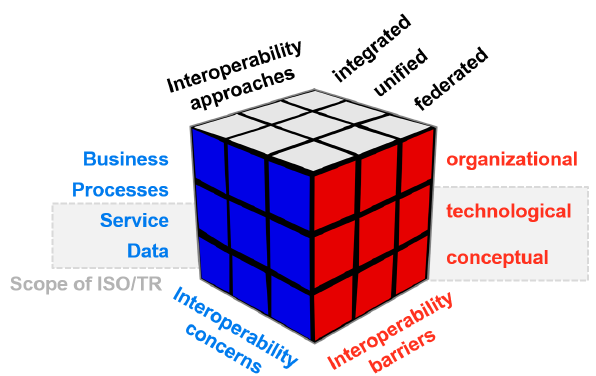
Figure 2. All levels (data, service, process and business) and interoperability aspects as defined by ISO 11354. The IS0/TR limites the scope to concerns { service, data } x barriers { technological, conceptual }